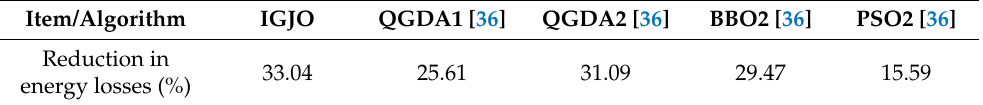
Table 9. Comparison of proposed methodology with previous studies.